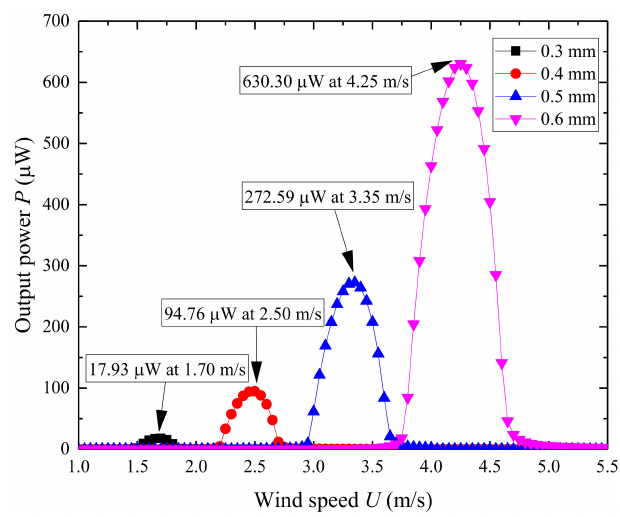
Figure 8. Variation of the output power P of UPEH as a function of the thickness of substrate layer.